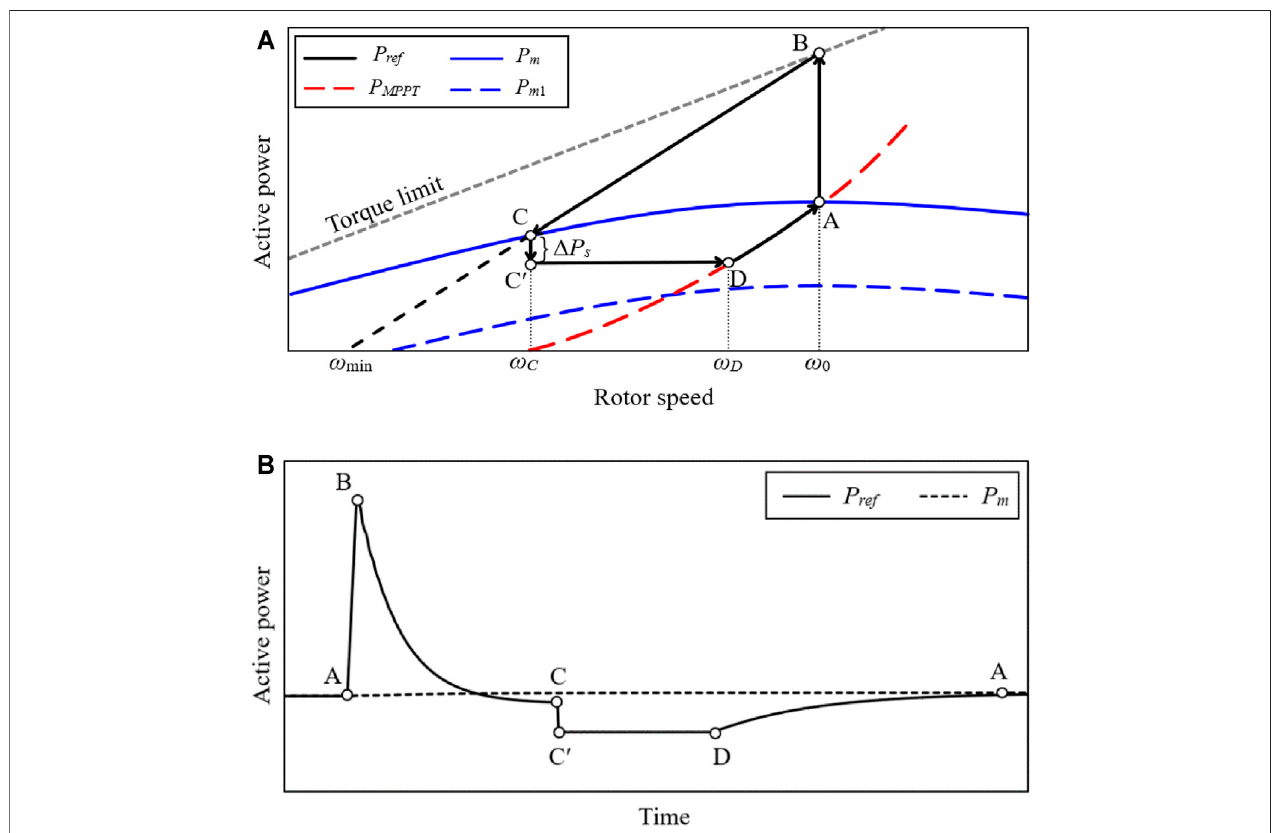
FIGURE 3 | Operational features of the conventional TLBIC scheme: (A) Power trajectory in the ω